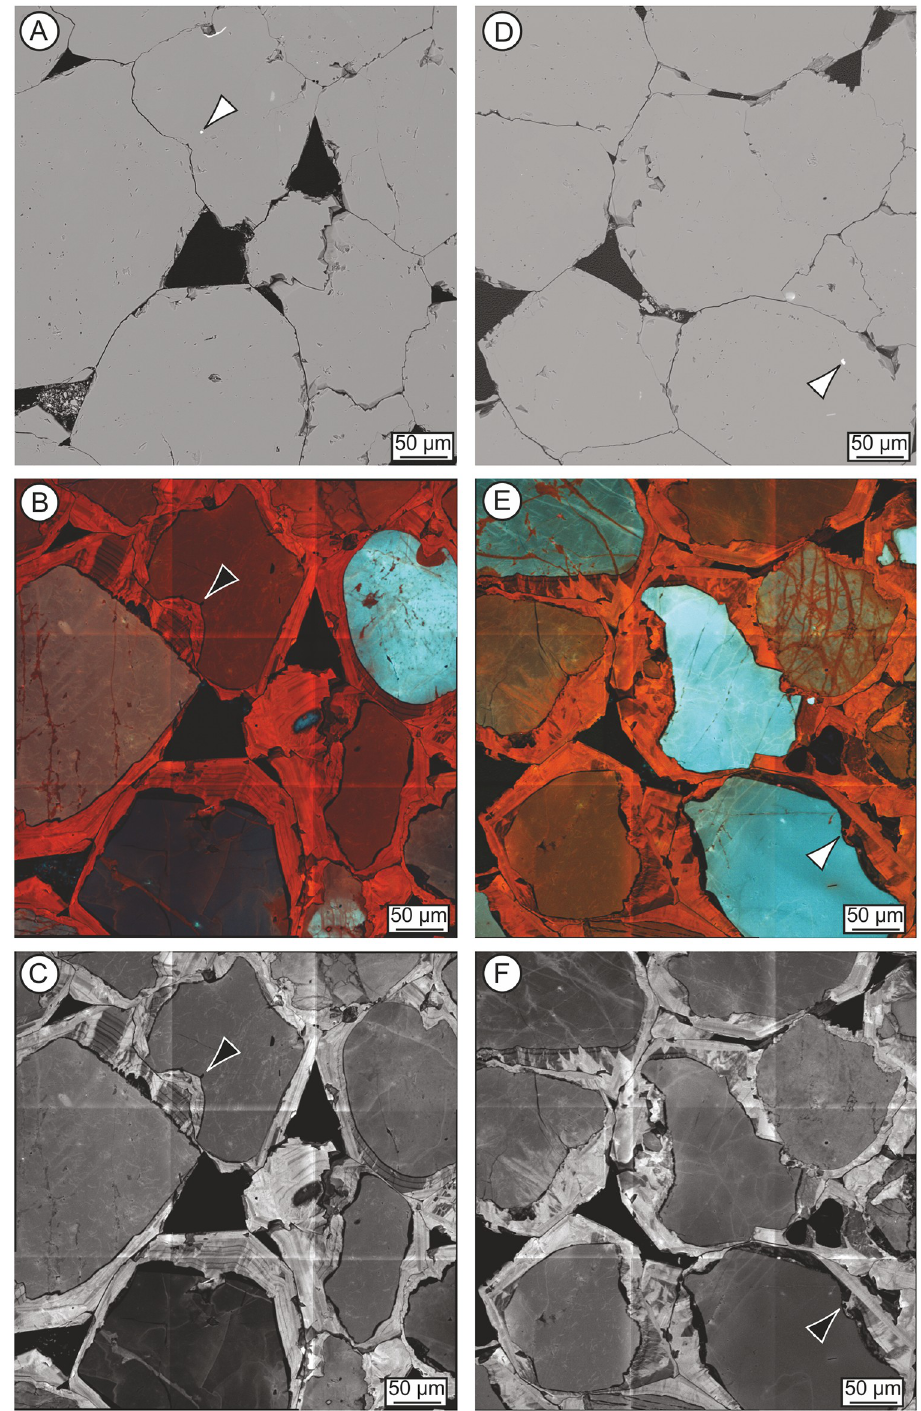
Fig 13. Variability in the quartz-rich host sediment and quartz cement within polished thin-sections SH2B (left hand column) and SH1B (right hand column) from the Phillips’ Core. Back-scattered electron (BSE) images (A, D; 786 nm pixel size) and cathodoluminescence (SEM-CL) images of the same areas (B, E—Red-Green-Blue composite; C, F—red component; 320 nm pixel size). Arrows show ~2–6 μ m zircon grains at the contact of a quartz grain and initial layer of non-luminescing quartz cement. These images are reproduced under a CC BY 4.0 license, with permission from The Trustees of the Natural History Museum, original copyright (2019).